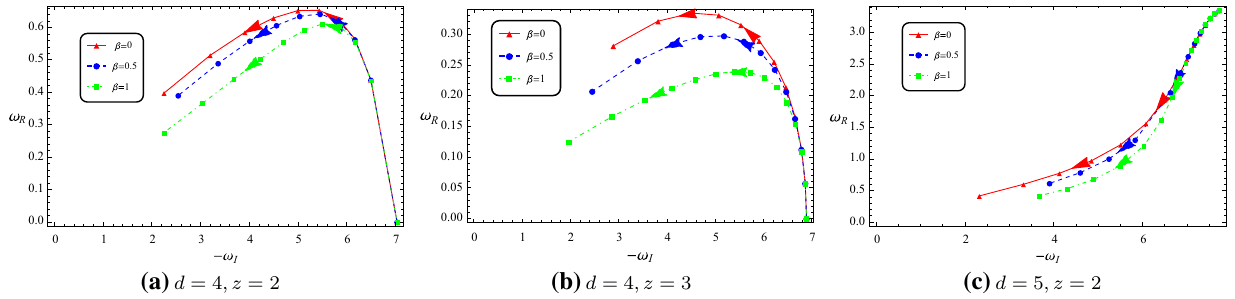
Fig. 1 The behaviors of real and imaginary parts of QNFs in the case with d (cid:7)= z , m 2 s = 1 / 4 and q s = 1 . 5 for different d , z , and β . The increase of the black holes charge q from 0 to near the extreme value in steps of 0 . 2 are shown with the arrows. Note that for each curve the extreme value of q is different